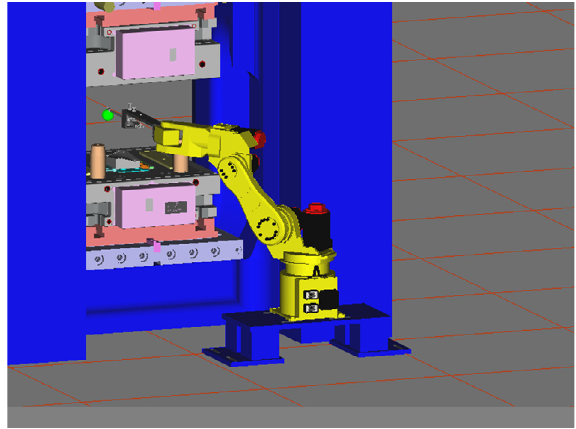
Figure 11. Manual spraying becomes robotically